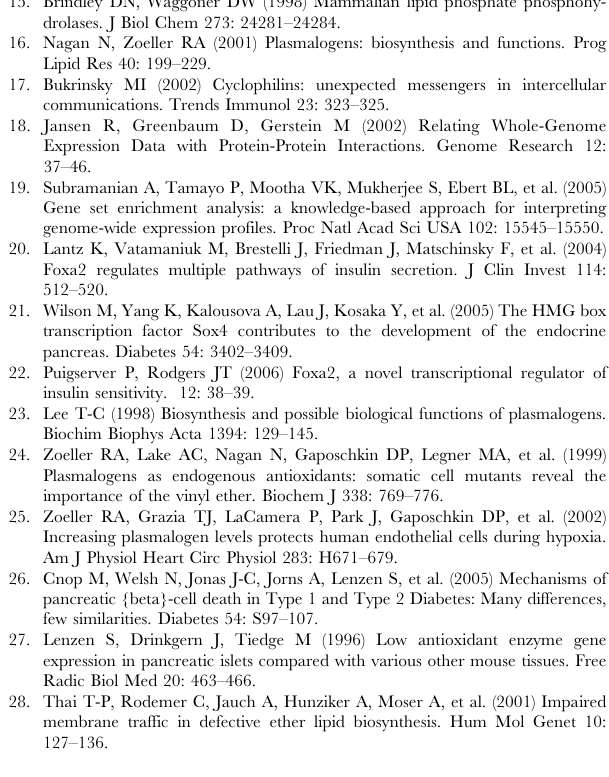
Figure S7 Meta-analysis for downregulated genes in BDC2.5/ NOD vs. NOD comparison. Genes are presented as rows and study group comparisons as columns. Found at: doi:10.1371/journal.pone.0007323.s016 (1.86 MB EPS) Figure S8 Meta-analysis for upregulated genes in BDC2.5/ NOD.scid vs. NOD.scid comparison. Genes are presented as rows and study group comparisons as columns. Found at: doi:10.1371/journal.pone.0007323.s017 (2.25 MB EPS) Figure S9 Meta-analysis for downregulated genes in BDC2.5/ NOD.scid vs. NOD.scid comparison. Genes are presented as rows and study comparisons as columns. Figure S10 Path scoring method. In order to calculate the score for the path, the edge weights are multiplied. All node weights are then summed up. In the end, the edge product and the node sum are multiplied. The total path score is thus (w(E12)* w(E23)*..* w((n-1)N)))*(W(N1) + W(N2) + .. + W(Nn)). Found at: doi:10.1371/journal.pone.0007323.s019 (1.00 MB